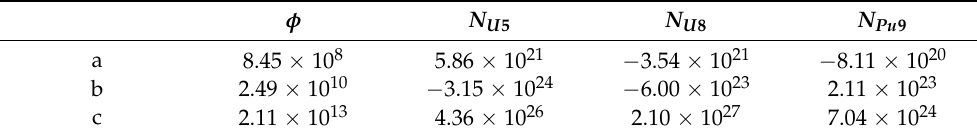
Table 3. Parameters of the conceptual point reactor for the equilibrium core of